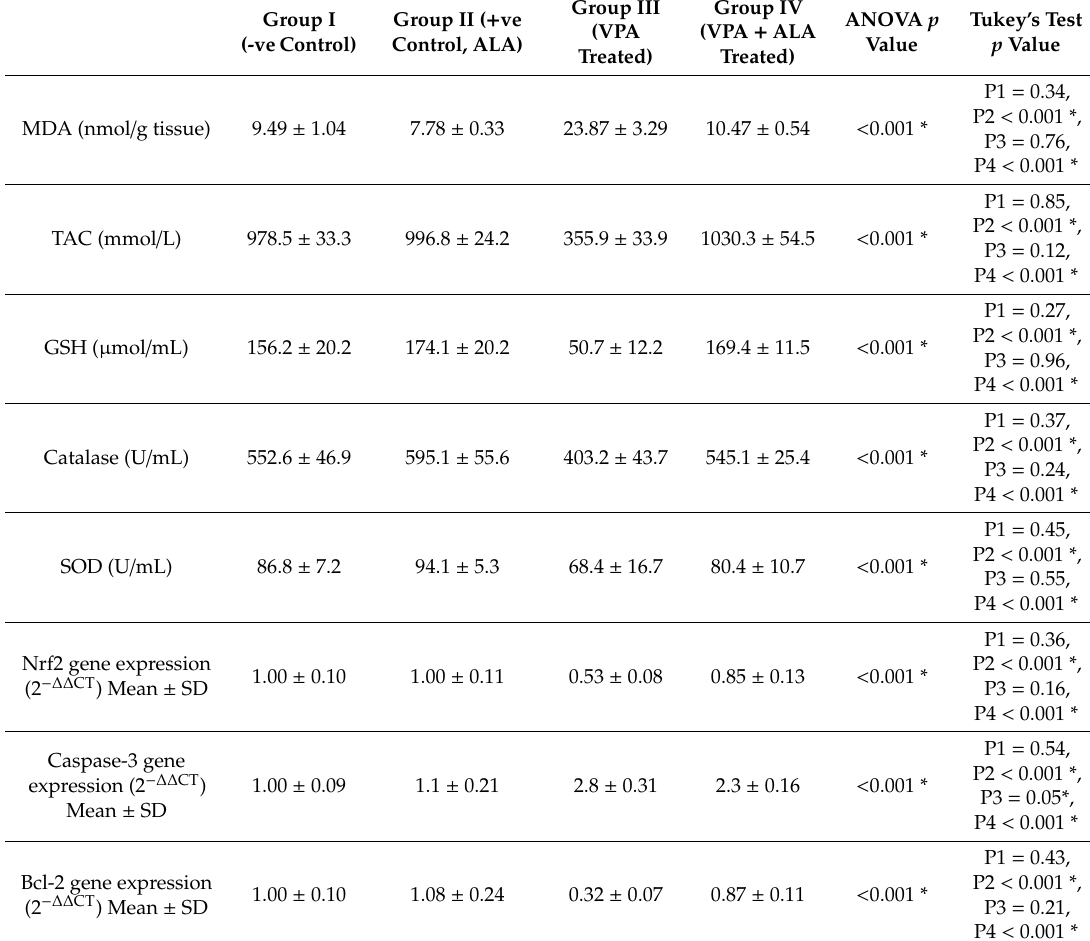
Table 2. The biochemical and molecular parameters (mean ± SD) of control and experimental groups.